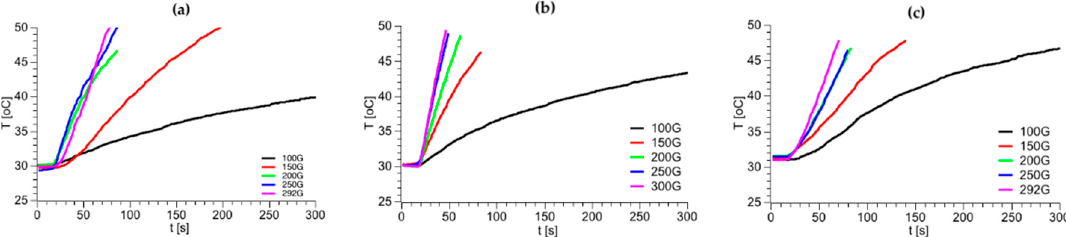
Figure 5. Heating of La@Fe 3 O 4 ( a ), La@Fe 3 O 4 -CEPA ( b ) and La@Fe 3 O 4 -CEPA@-trastuzumab ( c ) at 632.6 kHz frequency of alternating magnetic field and various magnetic amplitude.